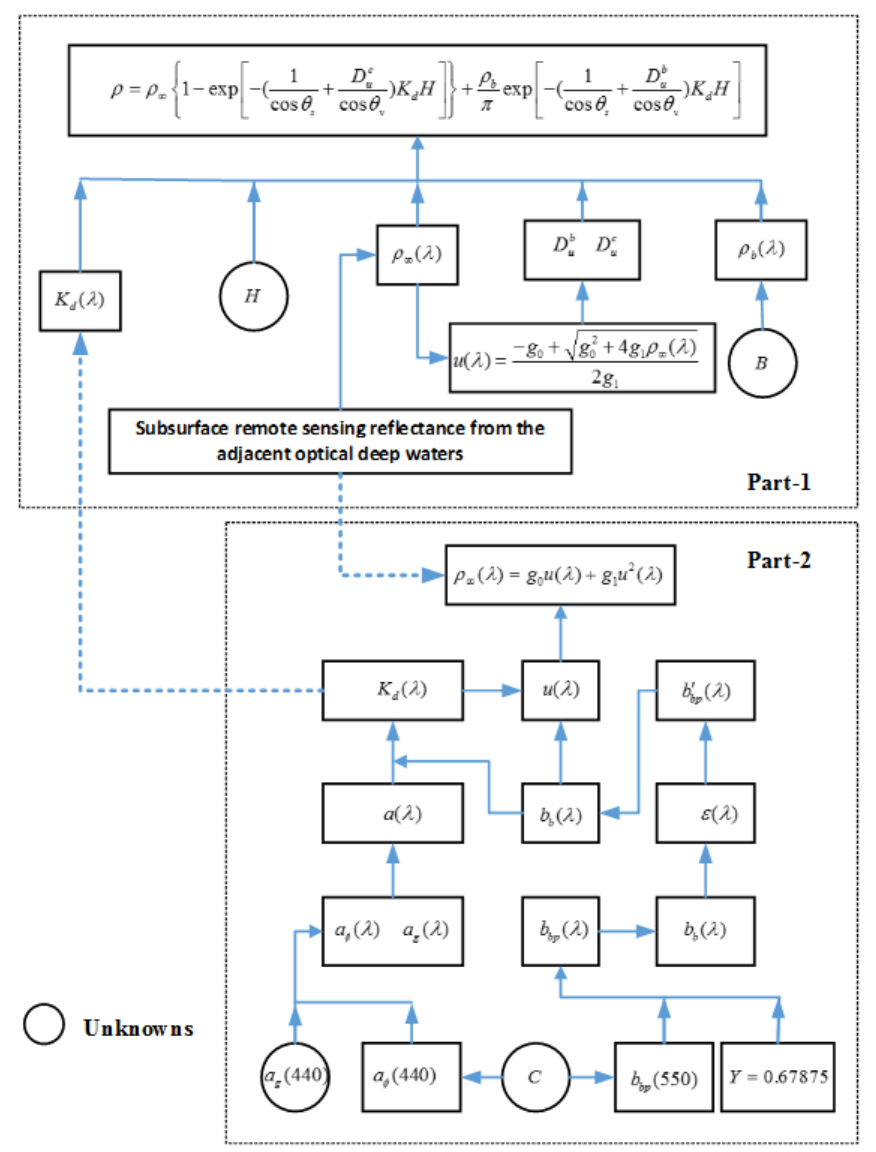
Figure 8. The two parts of the updated semi-analytic